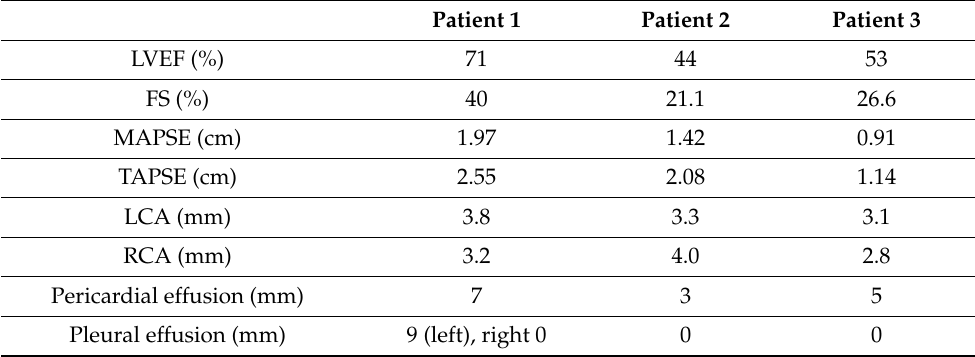
Table 2. Initial echocardiographic